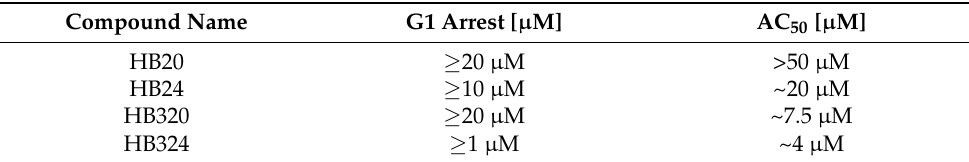
Table 1. Compounds and ligands tested in this study for induction of apoptosis. Nalm-6 cells were incubated with each agent for 24 h and 72 h. Proliferation was measured after 24 h using the CASY ® CellCounter and Analyzer System and apoptosis was determined after 72 h using modified cell cycle analysis involving propidium iodide-staining. G1 arrest means a proliferation inhibition equal to 100% or above, indicating occurring cell death. AC 50 is the concentration necessary to induce apoptosis in half of the cell population. Each value is the mean of three replicants ± standard deviation (SD).